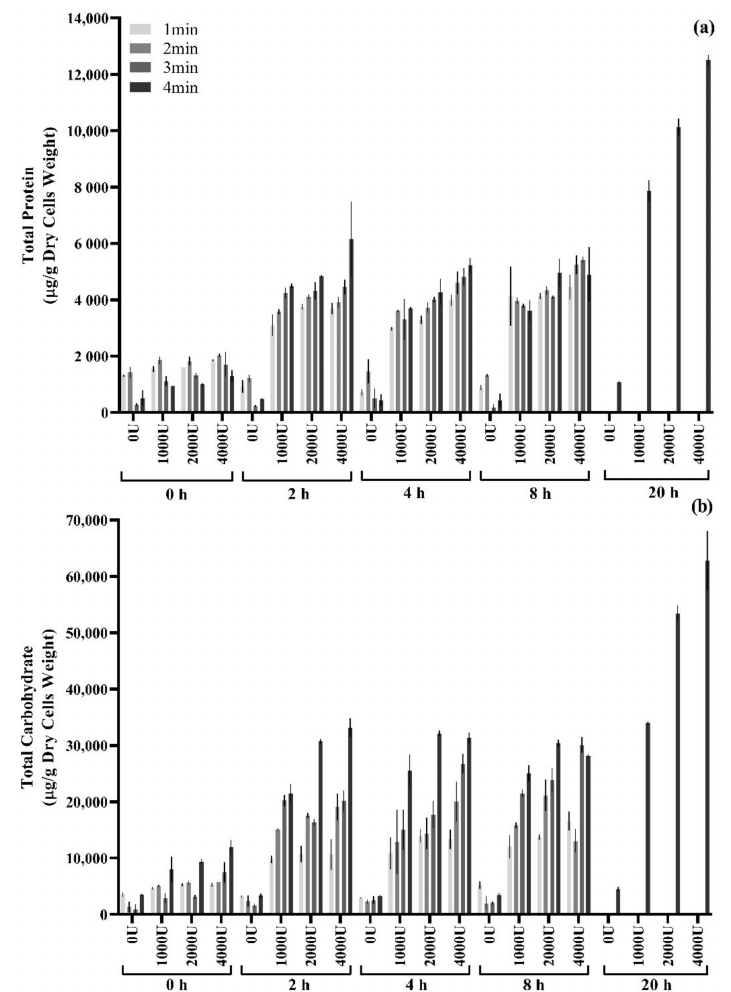
Figure 4. Total protein and carbohydrate content normalized by g dry cells weight of supernatant samples collected after enzymatic treatment (1000, 2000 and 4000 U lyticase/g dry cells weight incubated for 2, 4, 8 and 20 h at 37 ◦ C, with negative controls excluding enzyme and/or incubation time) of SB62 cells collected after 1, 2, 3 and 4 min of ultrasound treatment (50% duty cycle and 80% amplitude), with negative controls of non-sonicated samples. ( a ) Total protein determined by BCA protein quantification. ( b ) Total carbohydrate determined by the phenol-sulphuric acid test. The data points shown are means for duplicate experiments and the error bars indicate standard deviation between